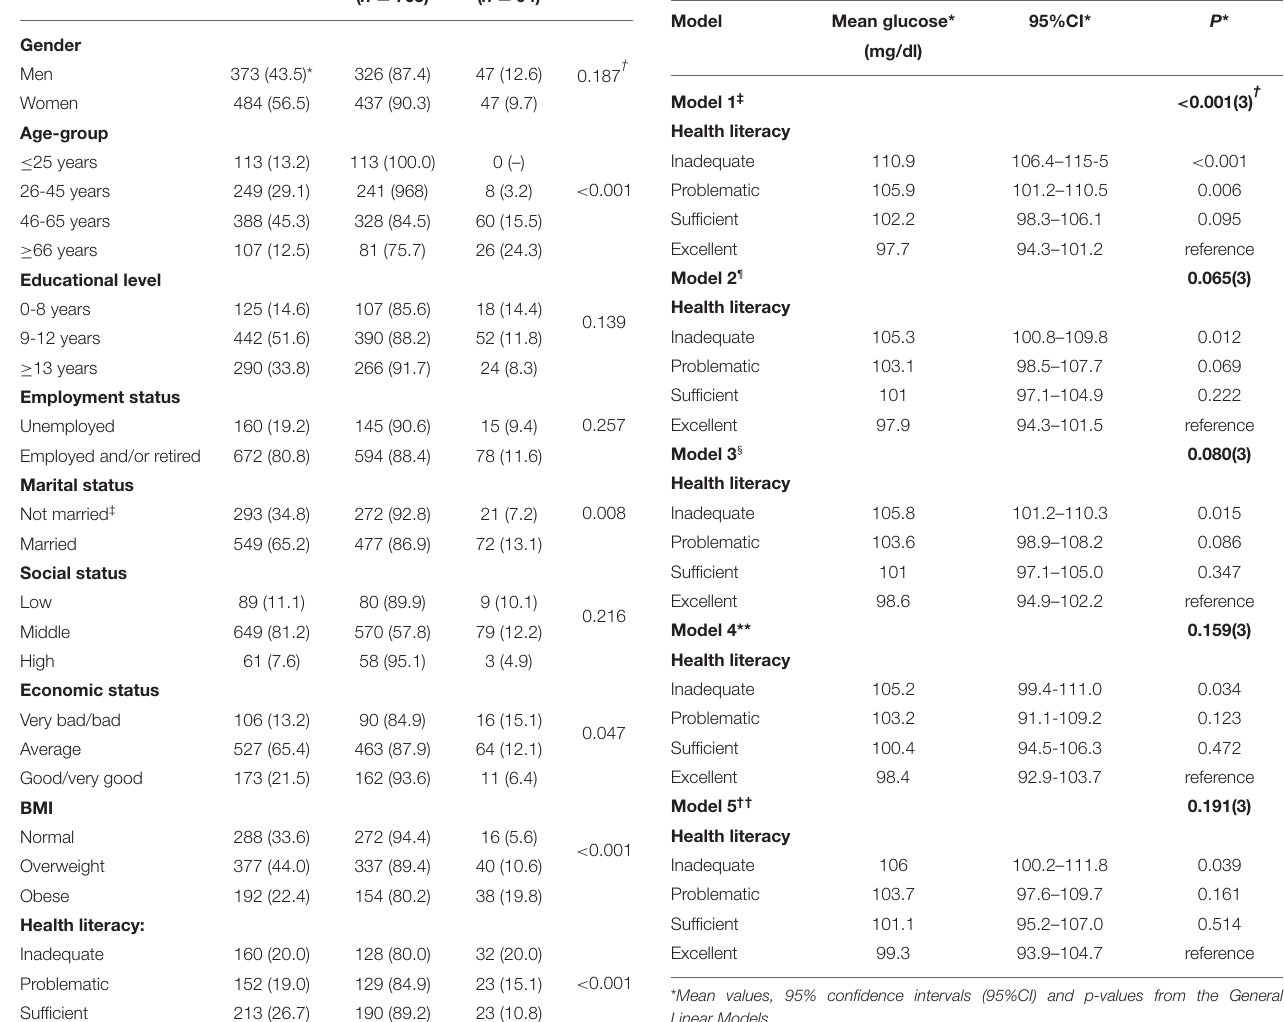
TABLE 3 | Association of blood glucose level with HL (General Linear